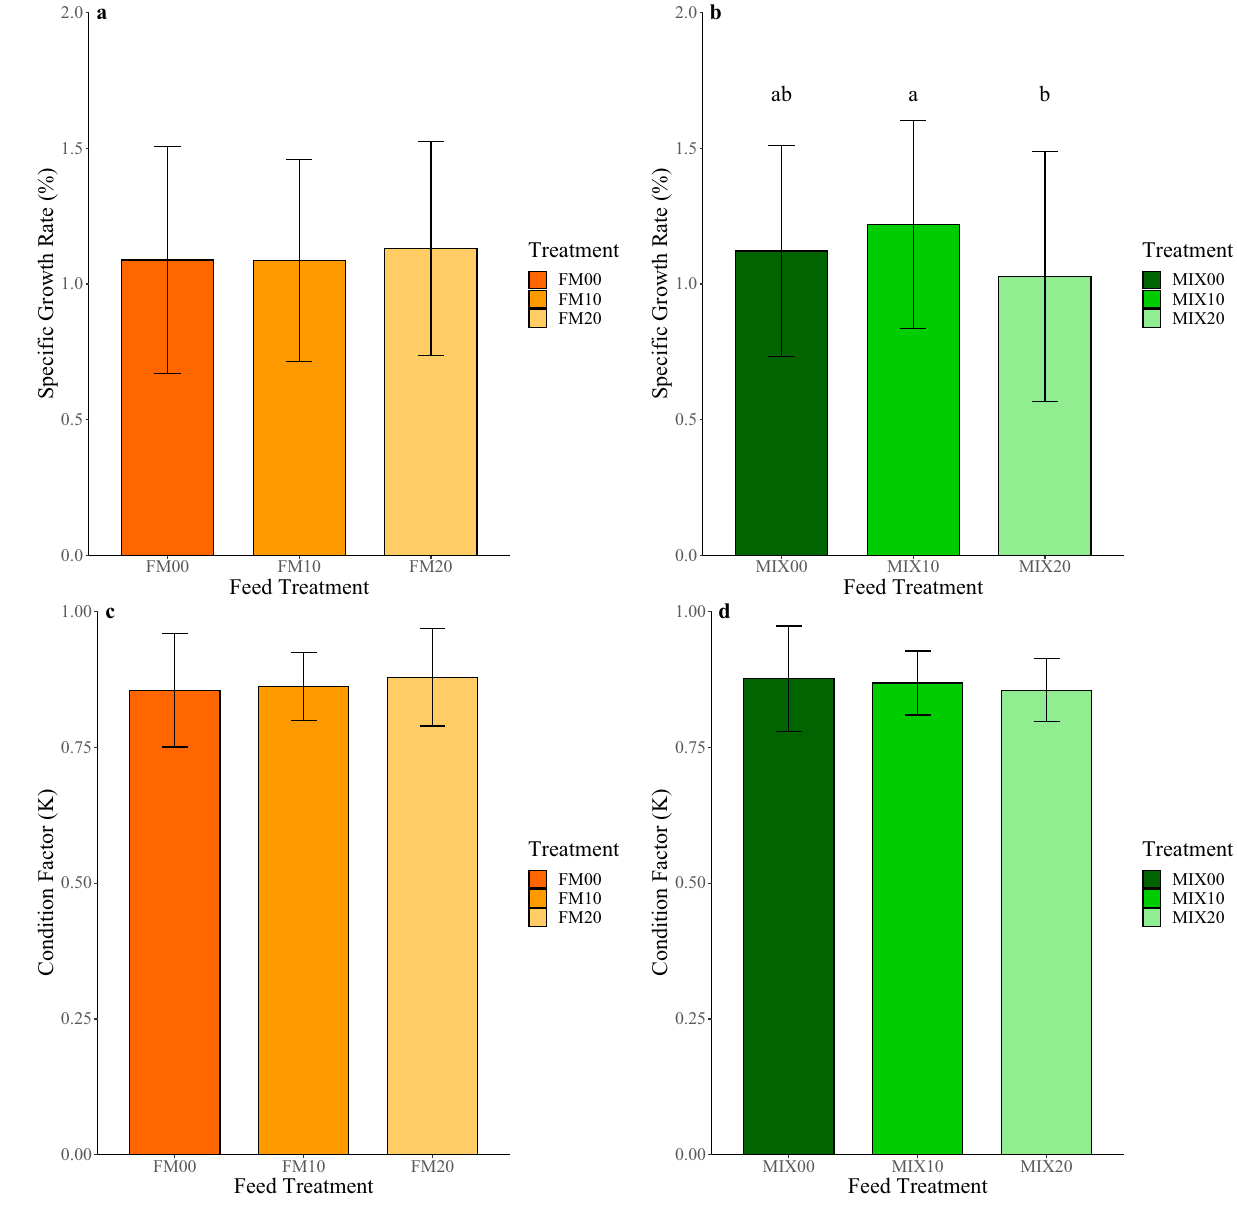
Figure 1. Bar plots of the specific growth rate (%) for ( a ) FM feed treatments and ( b ) MIX feed treatments, and bar plots of the condition factor (K) for ( c ) FM feed treatments and ( d ) MIX feed treatments. Error bars represent the standard deviation of the data and different lowercase letters indicate significantly different means ( P <